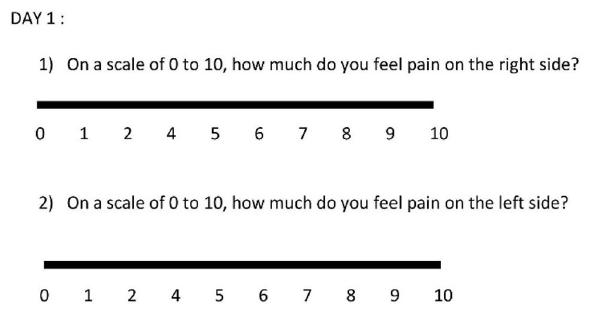
Figure 2. Example of the questionnaire measuring pain with a VAS.